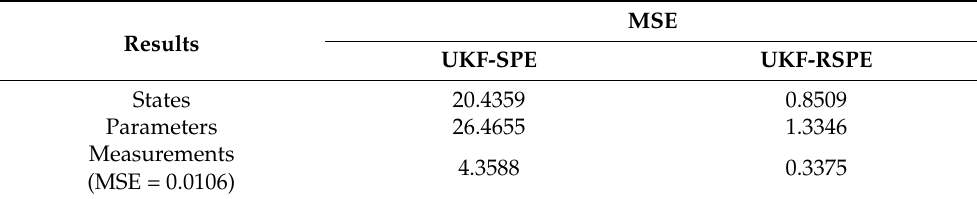
Table 1. Statistical information of estimated results in Case Study